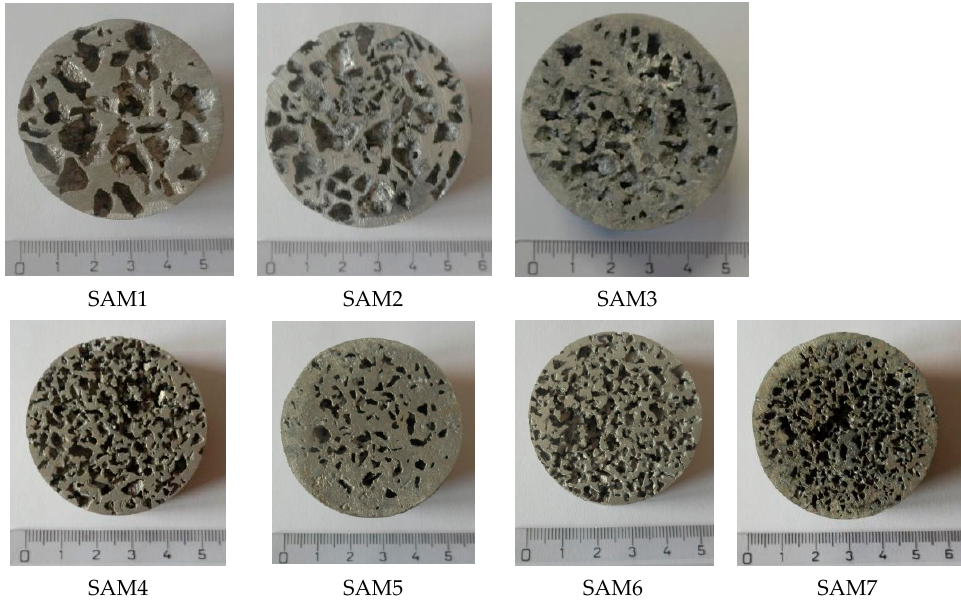
Figure 5. Manufactured samples of porous aluminium materials from AlSi12 alloy in the shape of a truncated cone.